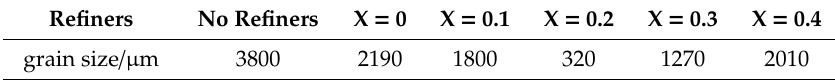
Figure 9. Microstructure of the industrial aluminum refined by different Al-TiO 2 -C-XLa 2 O 3 refiners ( a ) without refiners; ( b ) X = 0; ( c ) X = 0.1; ( d ) X = 0.2; ( e ) X = 0.3; ( f ) X = 0.4. Table 3. Grain size of the industrial aluminum refined by the Al-TiO 2 -C-XLa 2 O 3